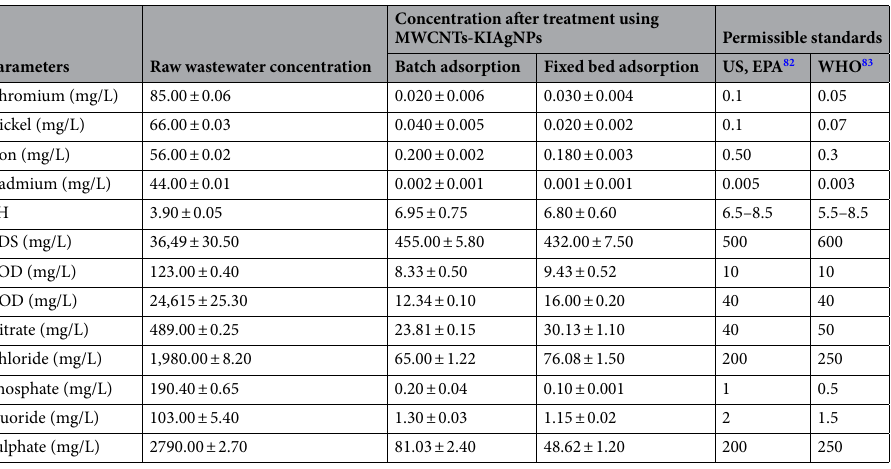
Table 8. Physico-chemical parameters of chemical industry wastewater and treated water in batch and fixed bed column.